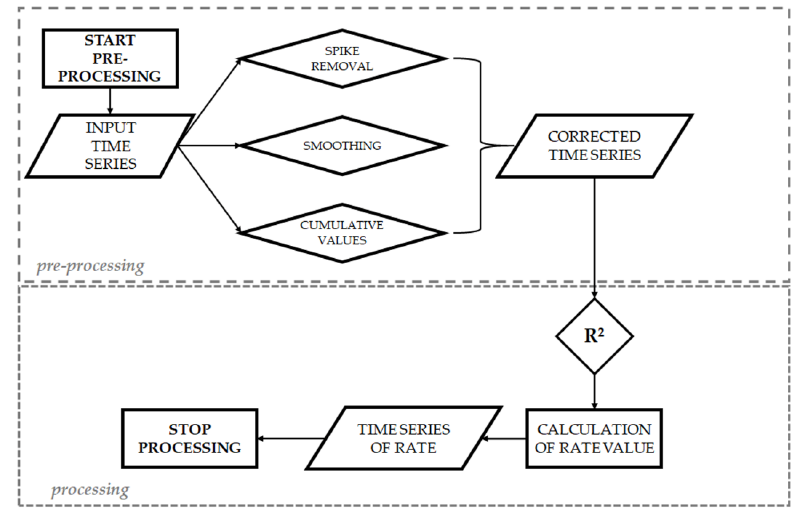
Figure 5. Flow chart illustrating the tools of the compiled script for rate analysis of the Acuto dataset, propaedeutic to cross-correlation statistical analysis of the obtained time series of rates.